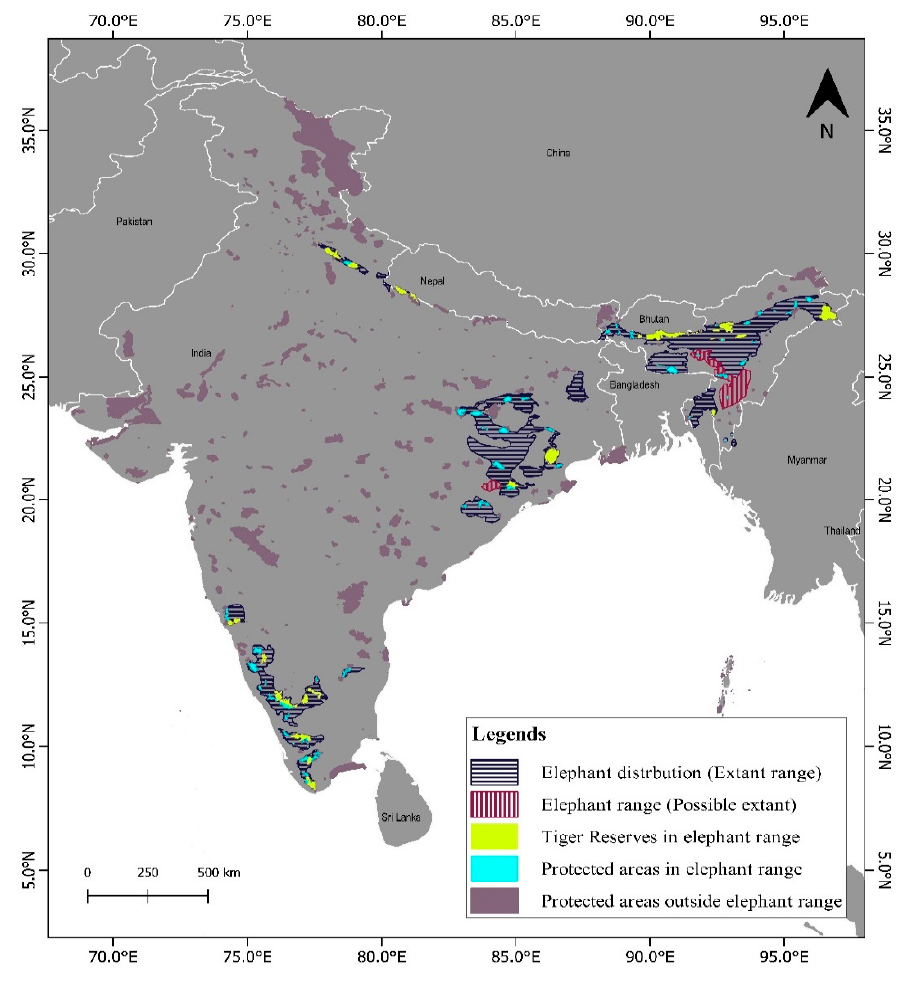
Figure 5. Map showing location of tiger reserves and protected areas in elephant range in India.